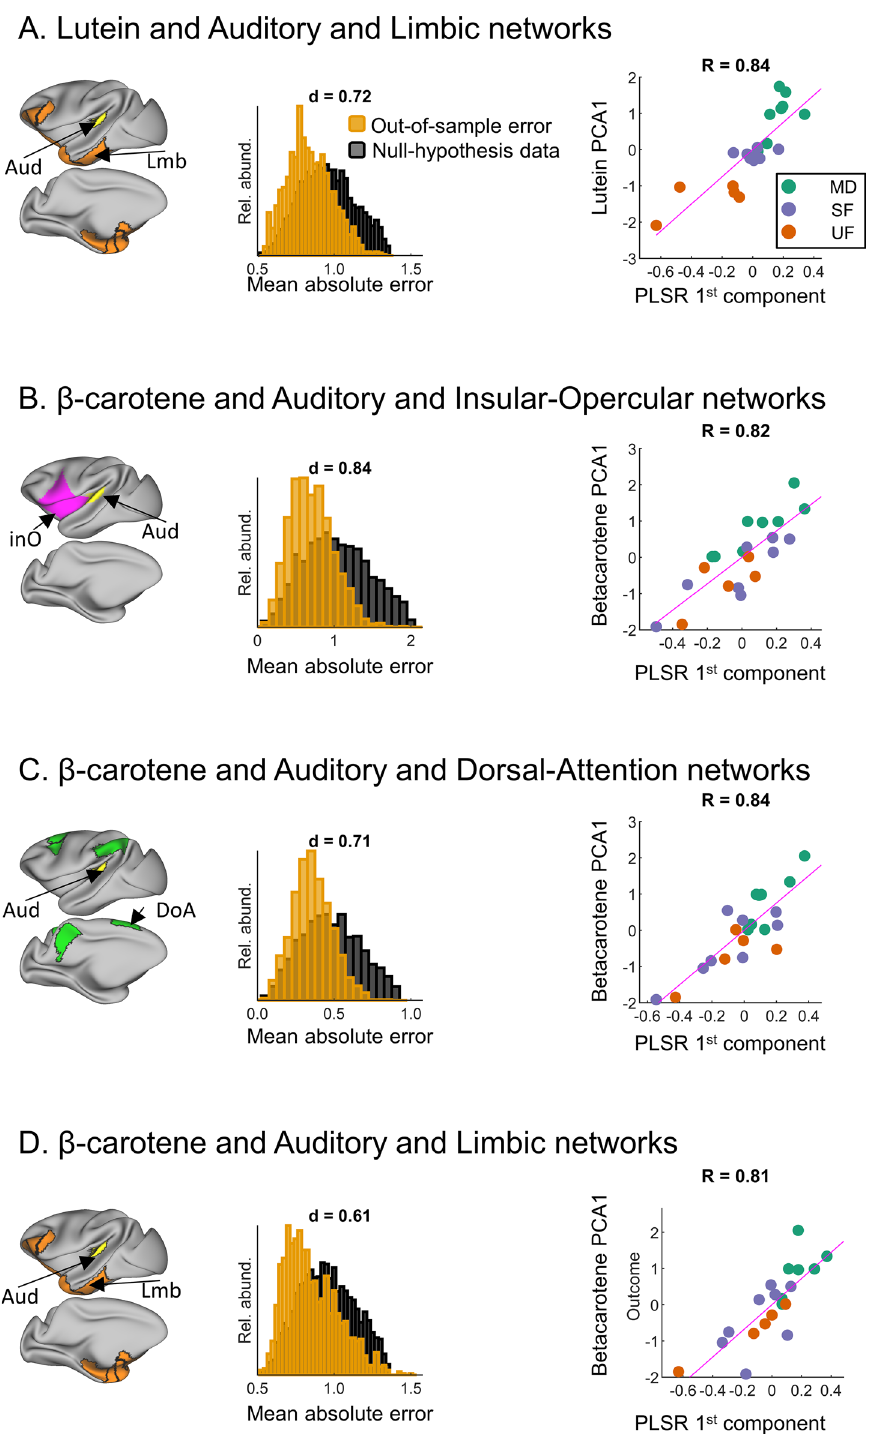
Figure 4. Associations between functional connectivity and carotenoid brain concentration. ( A ) Lutein brain concentration (first PLSR component) was associated with functional connectivity between the Auditory and Limbic networks (see Fig. 1 for network color codes). ( B – D. β-carotene brain concentration (first PLSR component) was associated with functional connectivity between ( B ). Auditory and Insular-Opercular; ( C ) Auditory and Dorsal Attention; and ( D ) Auditory and Limbic networks. Column 1 indicates the location of each functional network pair (see Fig. 1 for color codes) in a highly inflated projection of the brain cortex with left-lateral and left-medial views. Column 2 shows the distribution of the out-of-sample mean absolute errors (n = 1330, yellow), against null-hypothesis data (n = 4000, black). Column 3 is a scatter plot displaying, for each subject, the predicted outcome and the first PLSR component, color-coded by group: MD, breastfed (green); UF, un-supplemented formula (blue); SF, supplemented formula